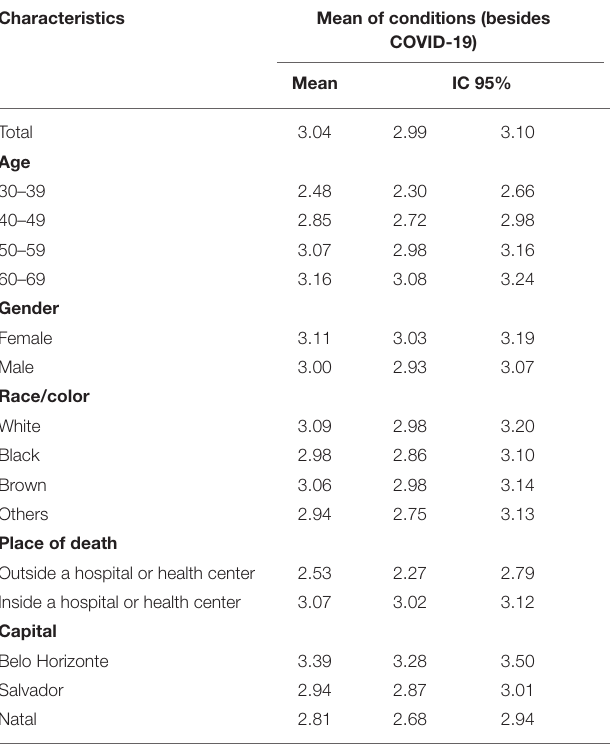
TABLE 4 | Mean number of conditions mentioned in death certificate according to characteristics of the deceased and local of death, at ages 30–69 years, in three Brazilian capitals,